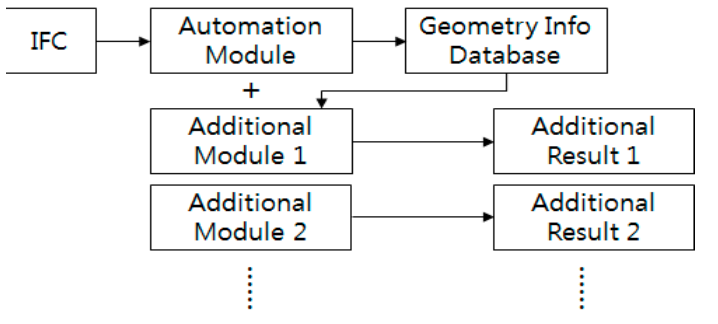
Figure 4. Expansion of automation module.